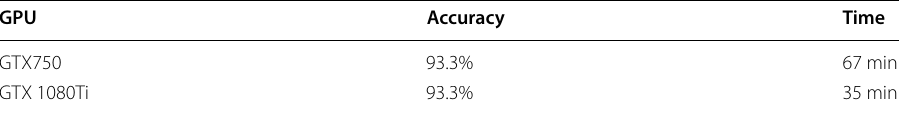
Table 2 Training statistics on different